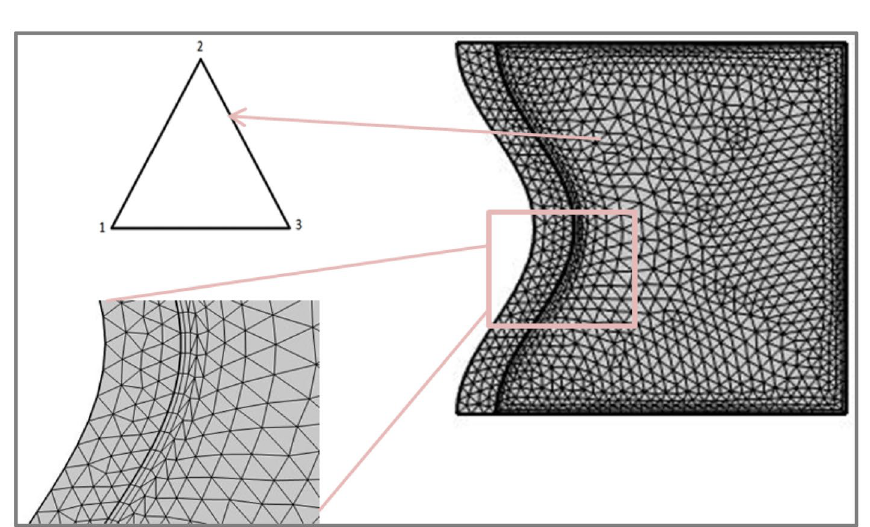
Figure 2. Grid distribution of the computational